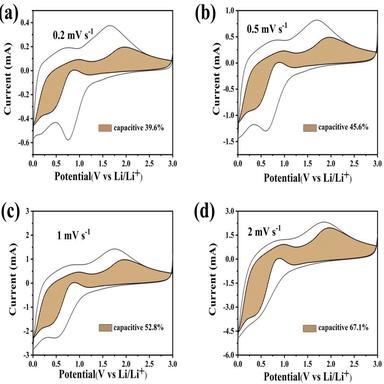
Calculated pseudocapacitance of ZFO/C-450 at various scan rates of (a) 0.2 mV s−1, (b) 0.5 mV s−1, (c) 1 mV s−1, and (d) 2 mV s−1.